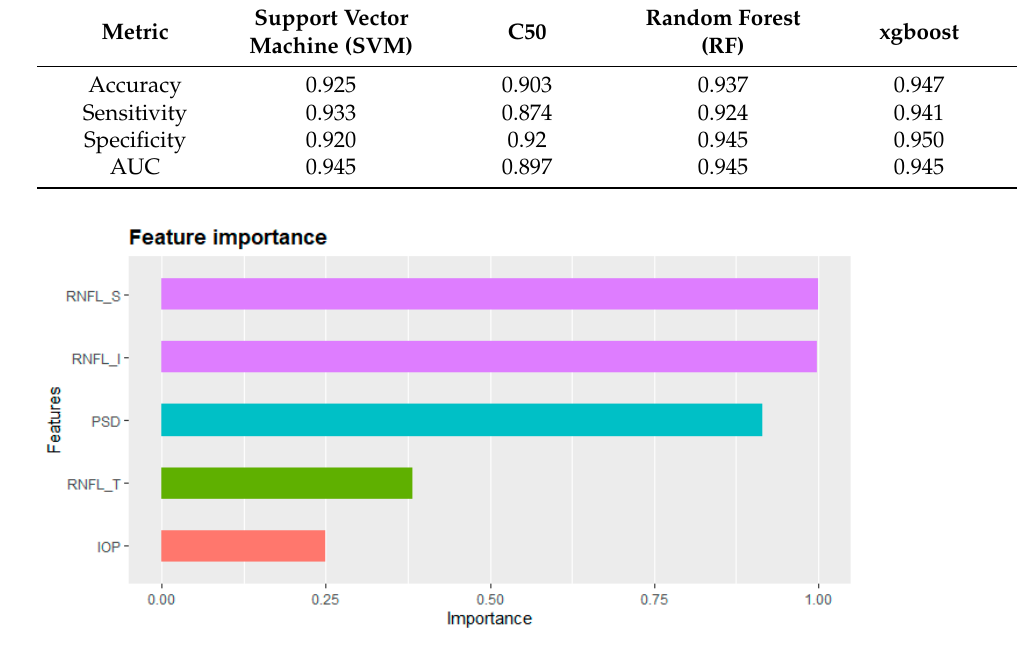
Figure 6. Feature importance of proposed model.